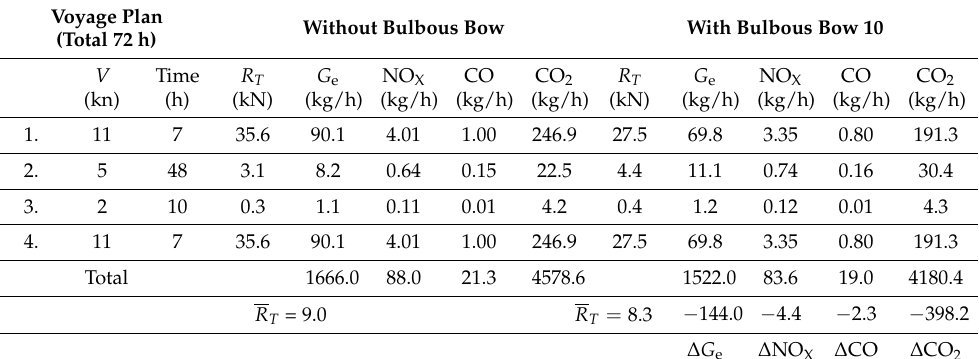
Table 9. Fuel consumption and emissions for a fishing voyage cycle of the B-410 boat with the bow bulb no